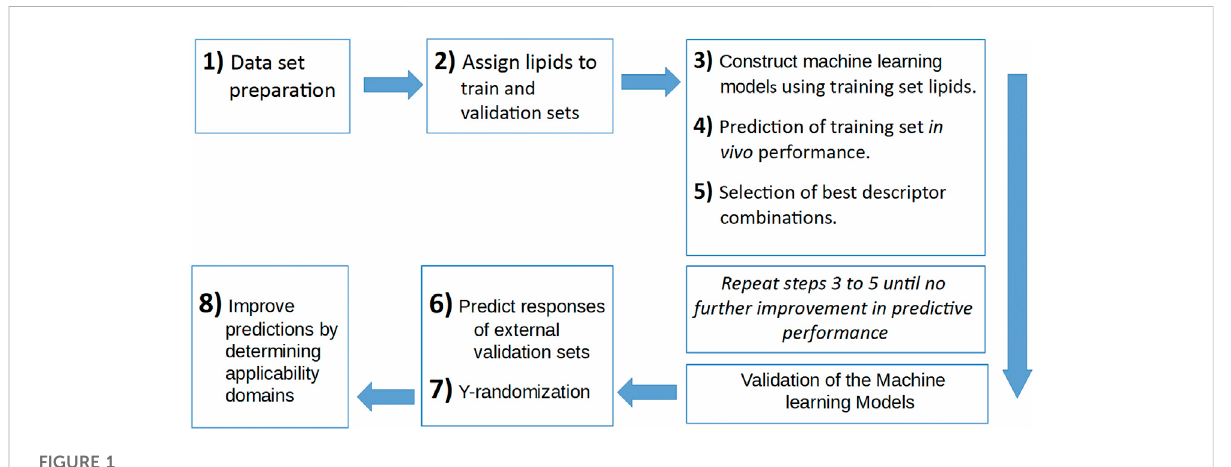
FIGURE 1 The work fl ow of the predictive model building